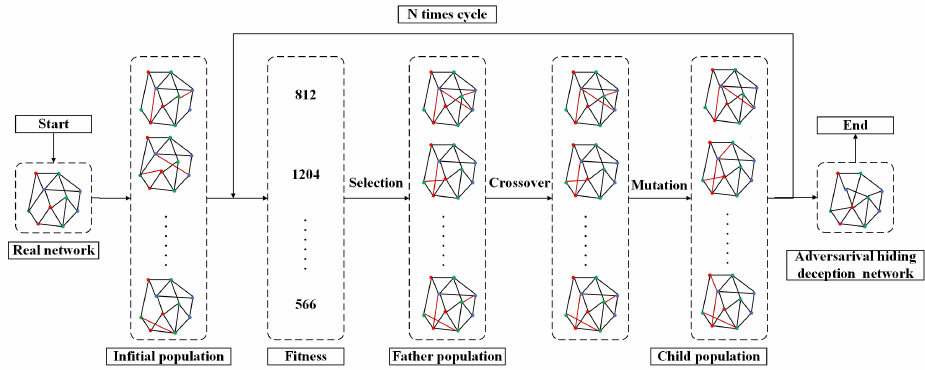
Figure 6. Schematic diagram of the adversarial hiding deception network